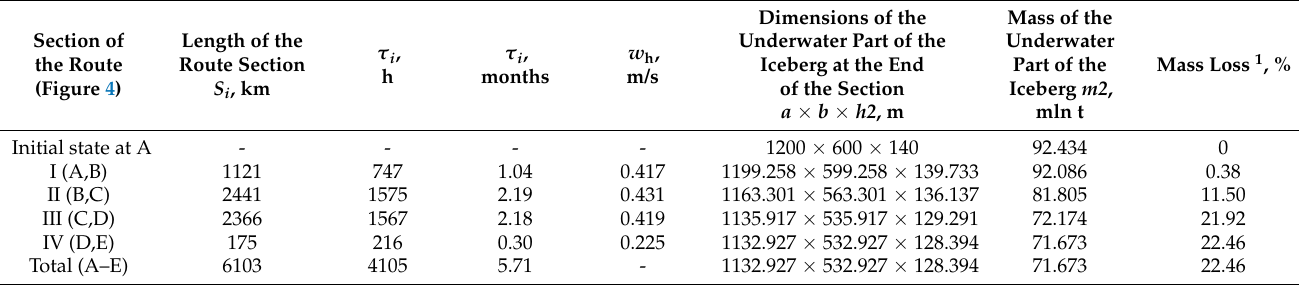
Table 7. The calculated mass loss of the underwater part of the iceberg for individual route sections and total route (own